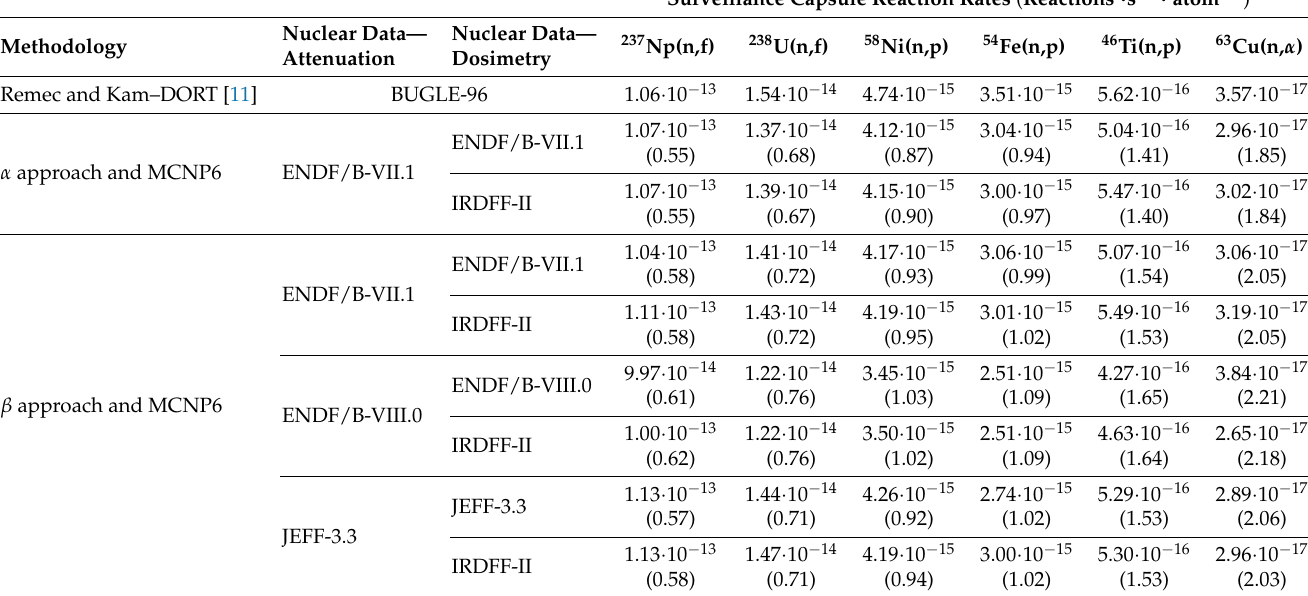
Table 5. Reaction rates obtained in the surveillance capsule. Values in parentheses indicate the standard deviations of MCNP6 tally responses (in units of %).